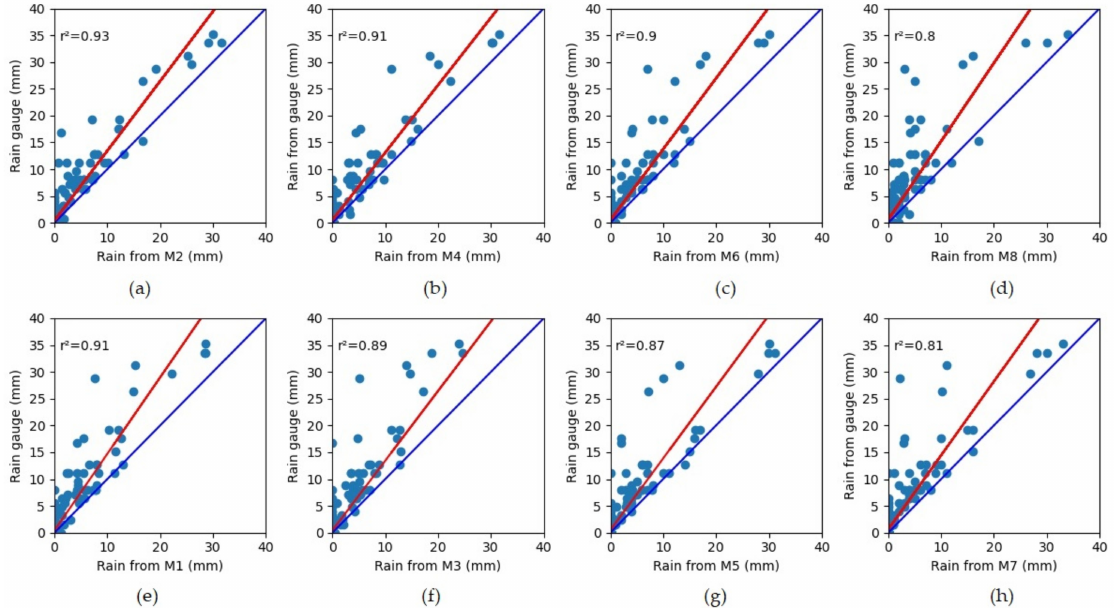
Figure A3. Comparison of the rain measurements resulting from the rain gauge data and by the mass variation in the system (rainfall are estimated as any increase in the total mass (lysimeter mass + exfiltration) of the lysimeter). The rainfall estimated from the lysimeter masses is lower compared to the rain gauge. Figure ( a – h ) represent, respectively, lysimeters 2, 4, 6, 8, 1, 3, 5, and 7.